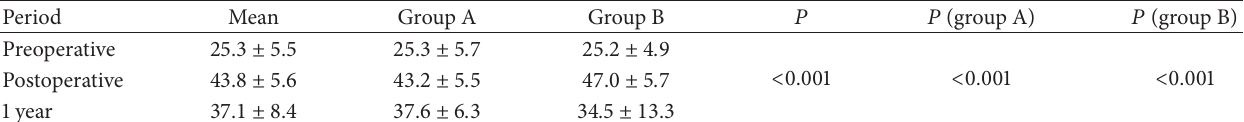
Table 2: Comparison of pretreatment and posttreatment mouth opening.